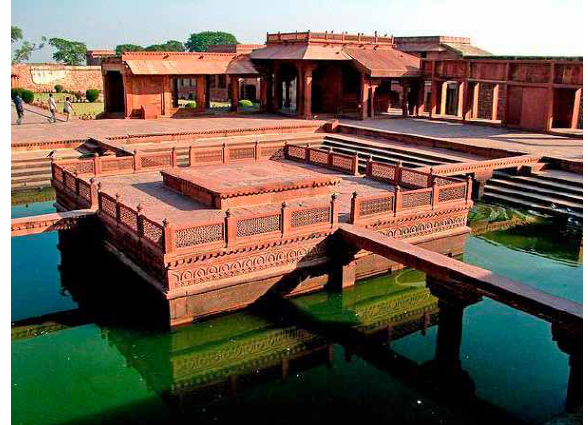
fig. 5. The anup Talao, fatehpur Sikri (Petrucioli